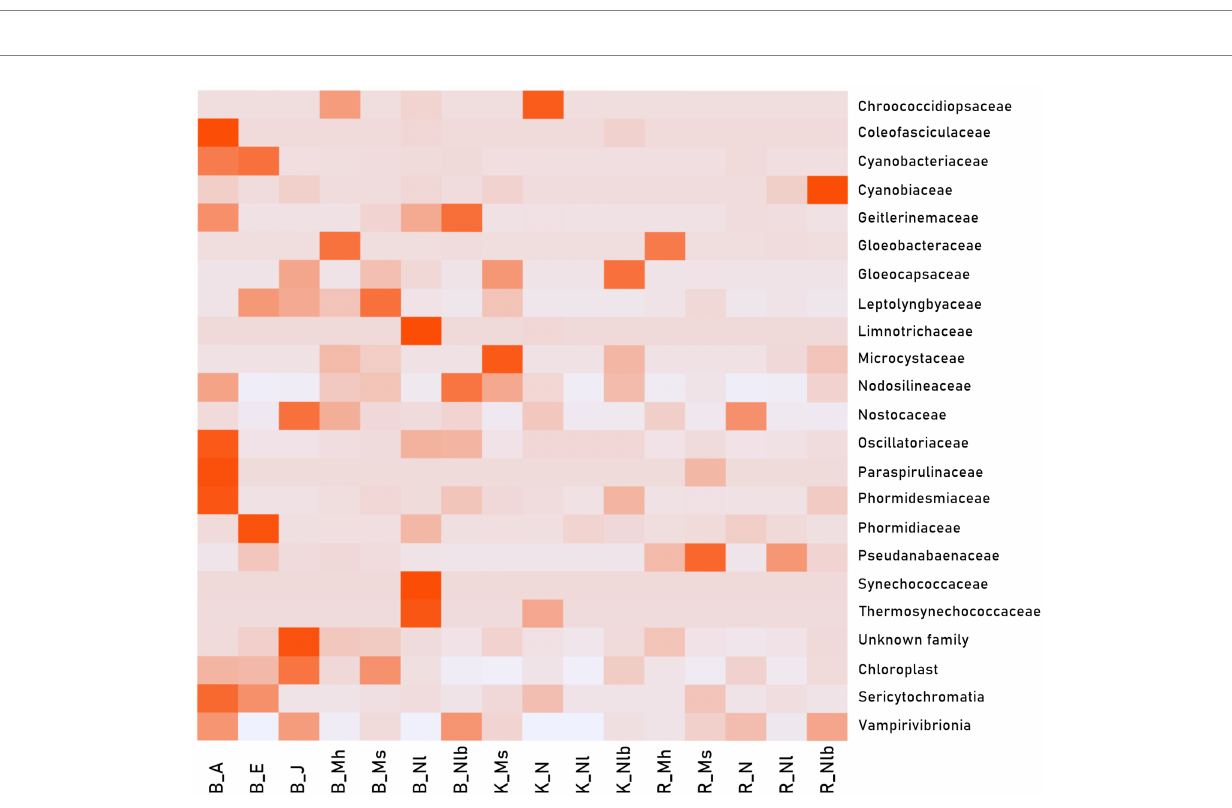
FIGURE 7 Heat map calculated from Oxyphotobacteria family reads and other “Cyanobacteria” (Chloroplasts, Sericytochromatia, Vampirivibrionia) in 49 samples merged into 16 representative groups: B_A - Bulunkul Amorphous; B_E - Bulunkul Epiphytes/epiliths; B_J - Bulunkul Jelly-like; B_Mh - Bulunkul Multilayer hard; B_Ms - Bulunkul Multilayer soft; B_Nl - Bulunkul Non-layered; B_Nlb - Bulunkul Non-layered beneath soil; K_Ms - Karakul Multilayer soft; K_N - Karakul Nostoc; K_Nl - Karakul Non-layered; K_Nlb - Karakul Non-layered beneath soil; R_Mh - Rangkul Multilayer hard; R_Ms - Rangkul Multilayer soft; R_N - Rangkul Nostoc; R_Nl - Rangkul Non-layered; R_Nlb - Rangkul Non-layered beneath soil. Dark red shades represent a high number of sequences and light gray color represents no